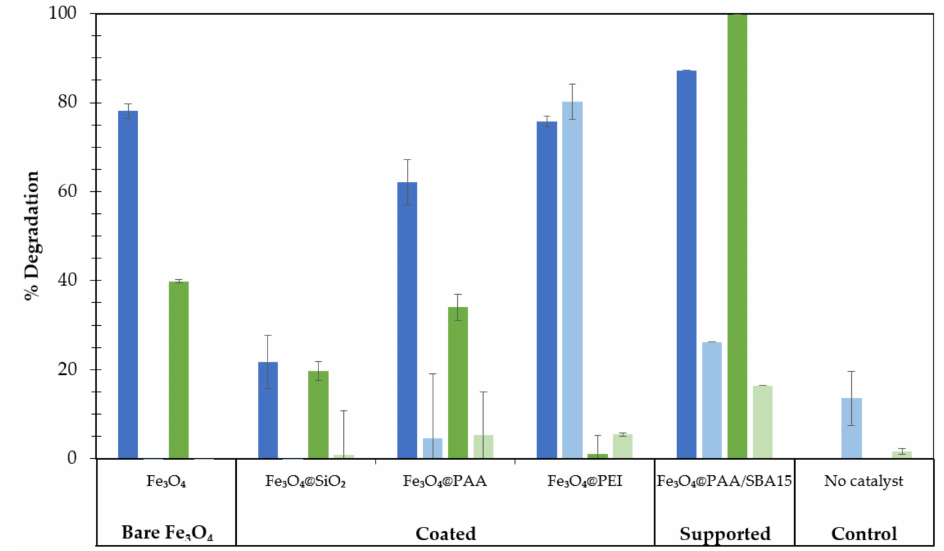
Figure 2. Percentage of dye decolorization (dark bars) and control experiments (light bars) for RB19 after 2 h (blue) and for MG after 4 h of reaction (green), using different Fe 3 O 4 -stabilized MNPs as heterogeneous Fenton catalysts. Operational conditions: [Fe] = 200 mg L − 1 , [H 2 O 2 ] = 100 mg L − 1 , pH 3, V = 10